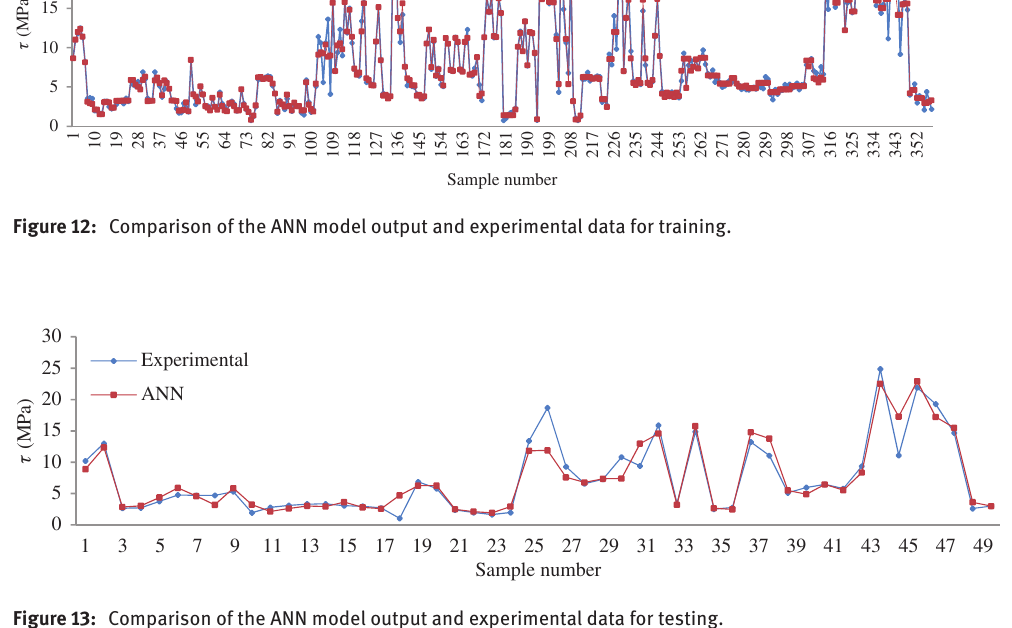
The results of output data for different models’ outputs are compared with experimental data. In the horizontal axis, the sample numbers are given while the vertical axis shows bonding strength in MPa. Figures 12 and 13 indicate